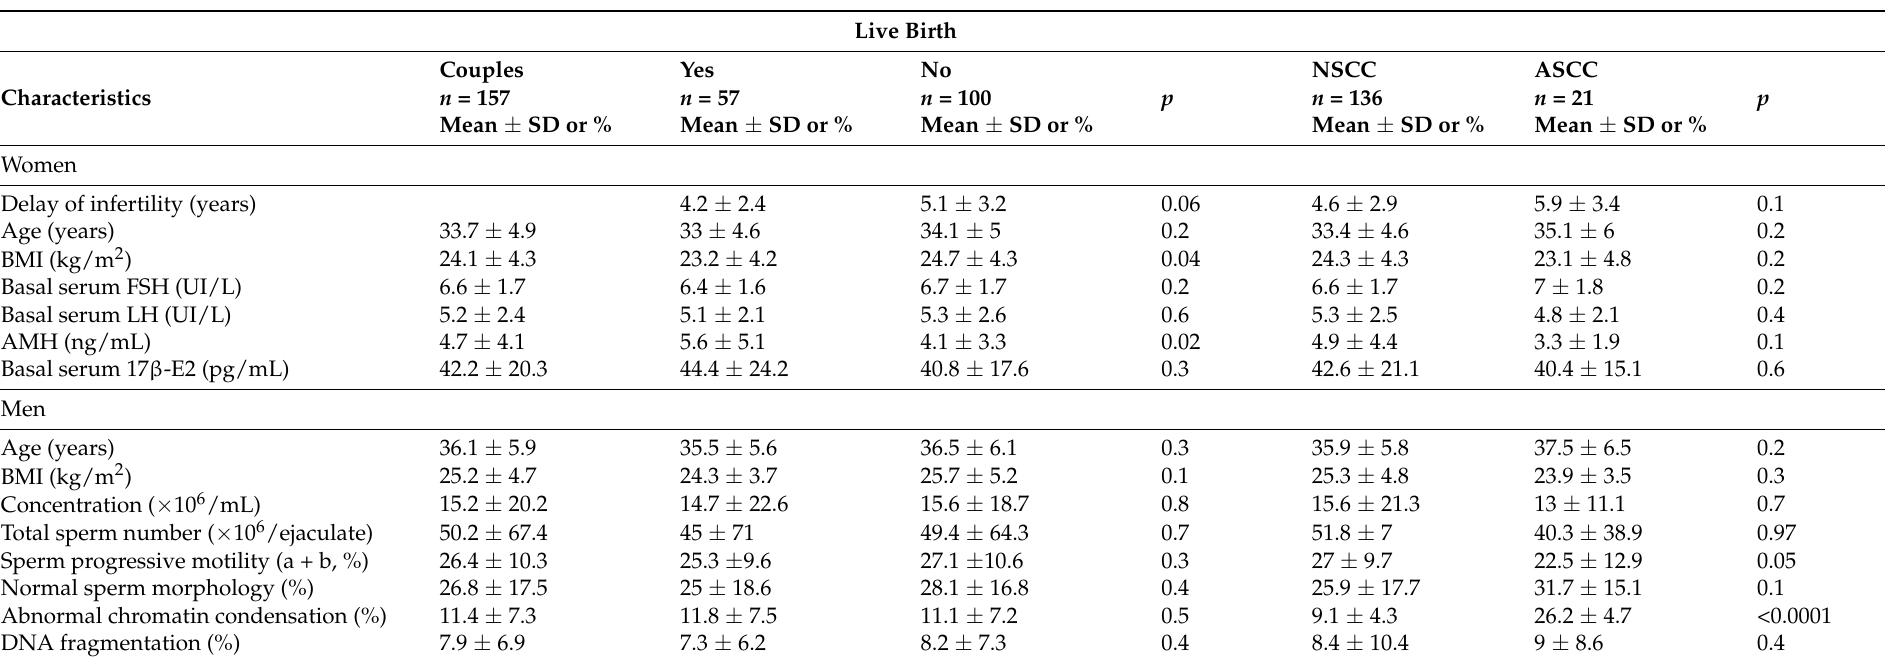
Table 1. Demographic and clinical characteristics, conventional semen parameters and sperm nuclear damage (chromatin condensation defect and